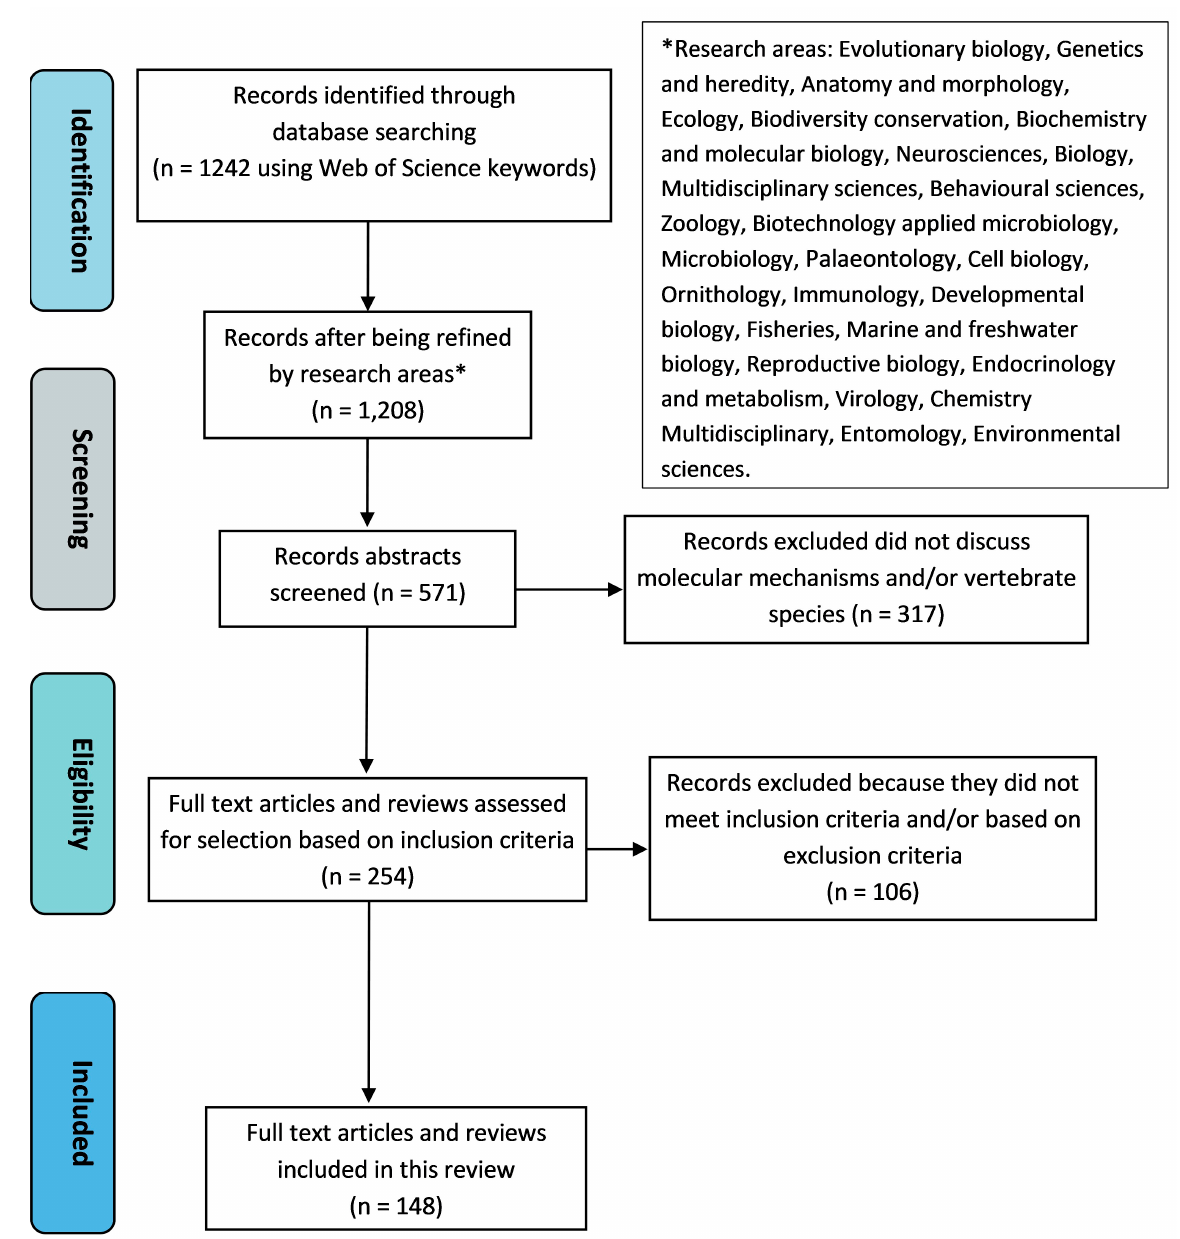
Figure 3. PRISMA flow diagram for systematic review of molecular mechanisms underlying verte- brate adaptive evolution. Records were identified for the years 2016–2022 using the Web of Science database. They were further refined to only include records from relevant research areas. Inclusion criteria: research articles or reviews that investigated or discussed molecular mechanisms involved in adaptive evolution and/or evolution of a trait that was shown to increase fitness. Exclusion criteria: research articles or reviews that described observations suggesting adaptive evolution of a trait (i.e., signatures of selection) but neither offered detailed information about the underlying mechanisms for adaptive evolution nor were supported by other articles that did investigate the underlying mech- anism; research articles that deemed their results inconclusive or in need of validation, and/or found no evidence to support the adaptive molecular mechanisms they were investigating; and research articles or reviews that described the evolution of a trait that had not been classified as adaptive. In this search, we selected 148 papers, and 2 additional papers were later included, following the second literature search (see the main